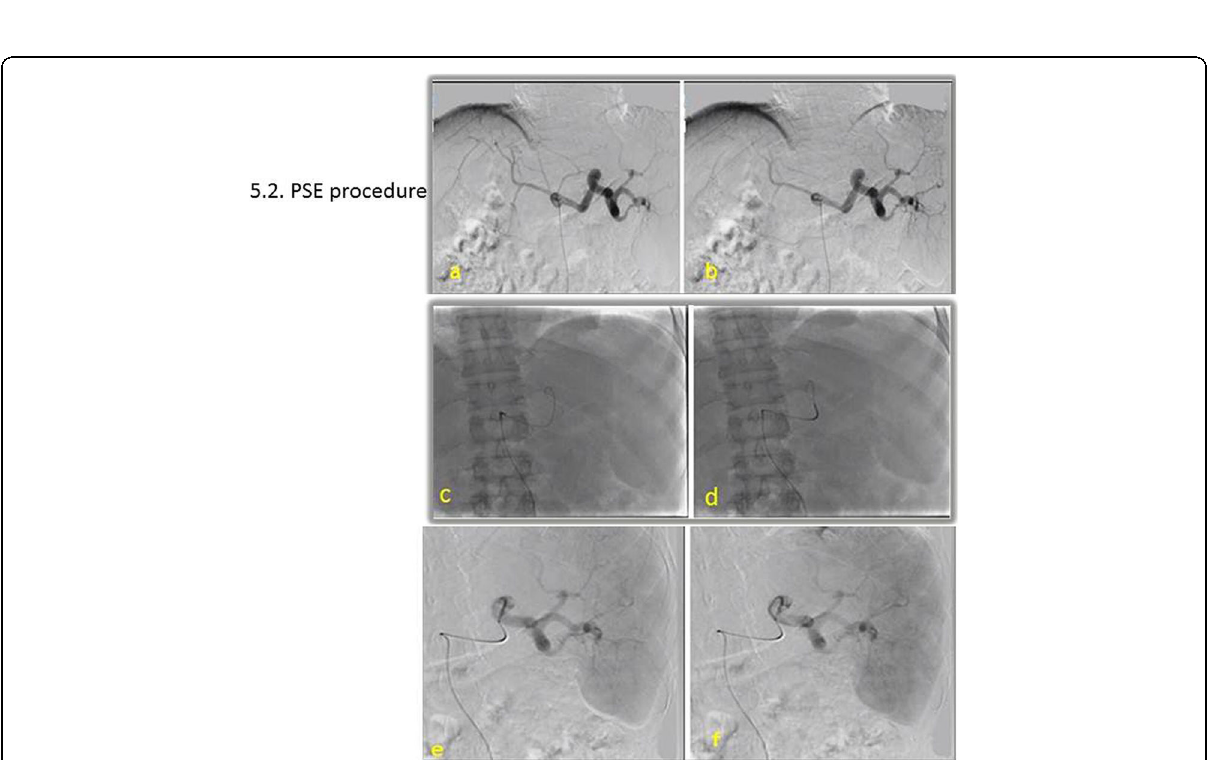
Fig. 11 Embolization procedure DSA of the celiac trunk and splenic artery before embolization. a , b The origin of splenic artery. Images showing both guide wide and cobra catheter advancement proximally within splenic artery. Selective splenic artery angiographic images showed segmental branches of the splenic artery with no pancreatic or gastric branches denoting very good position for embolization. Post-embolization angiography. a , b Splenic angiography after the beginning of the embolization showing insufficient embolized